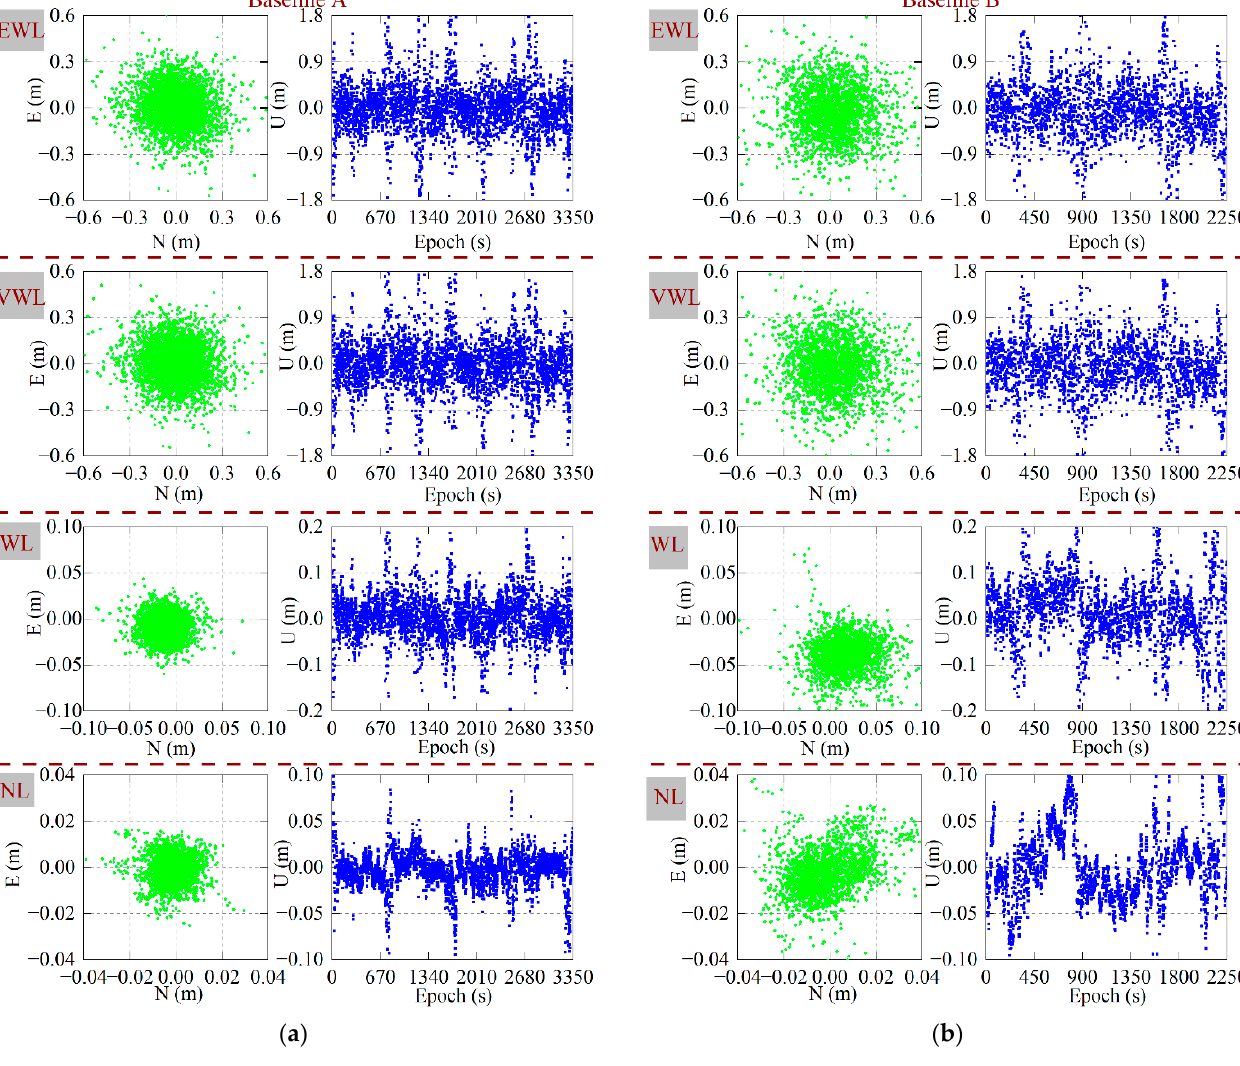
Figure 11. Time series of the N, E, U direction of the EWL, VWL, WL, and NL observations at baseline A and baseline B. ( a ) Baseline A. ( b ) Baseline B. Table 8. Positioning accuracy of different combinations of observations